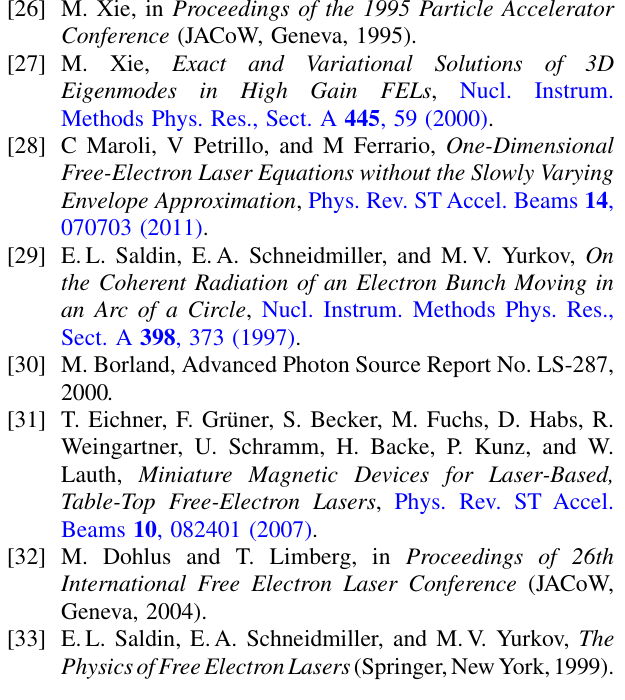
Table-Top Free-Electron Lasers , Phys. Rev. ST